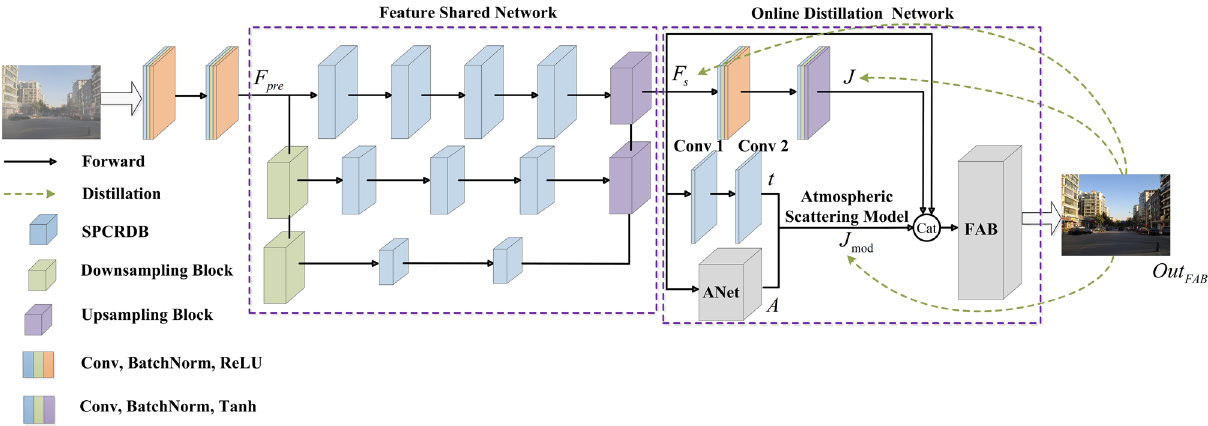
Figure 2. The general network structure of